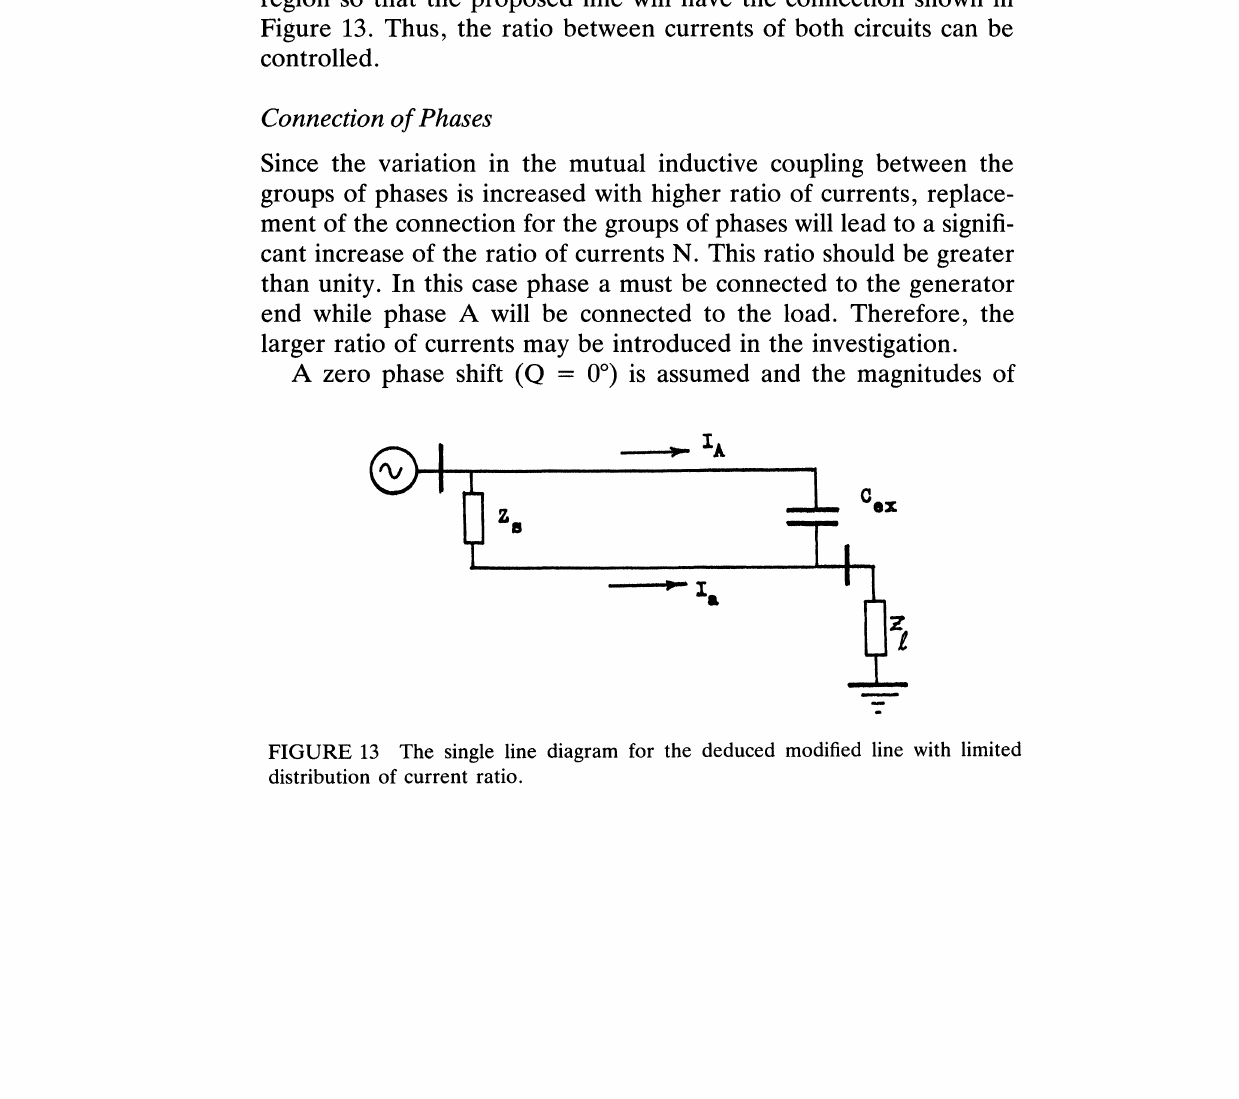
FIGURE 13 The single line diagram for the deduced modified line with limited distribution of current